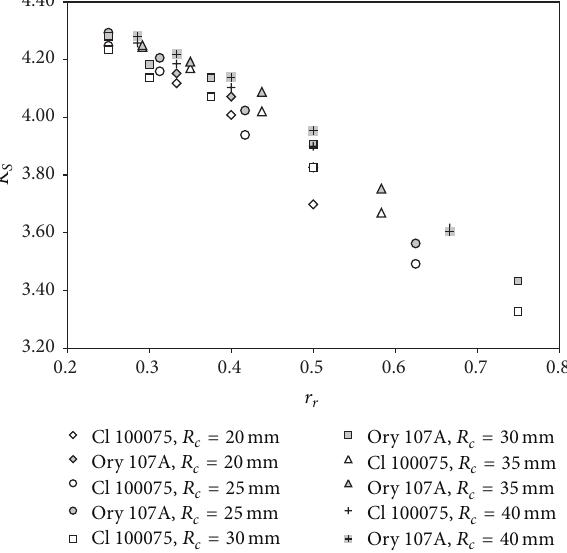
Figure 2: Simplified anemometer factor, 𝐾 𝑆 , as a function of the ratio of the cup radius to the cup center rotation radius, 𝑟 𝑟 ( 𝑟 𝑟 = /𝑅 𝑅 𝑐 𝑟𝑐 ), regarding the calibrations performed on the Climatronics 100075 anemometer (Cl 100075; white symbols) and the Orny- tion 107A anemometer (Ory 107A; grey symbols) [21]. Both were equipped with 𝑅 𝑐 = 20 mm cups (rhombi), 𝑅 𝑐 = 25 mm cups (circles), 𝑅 𝑐 = 30 mm cups (squares), 𝑅 𝑐 = 35 mm cups (triangles), and 𝑅 𝑐 = 40 mm cups